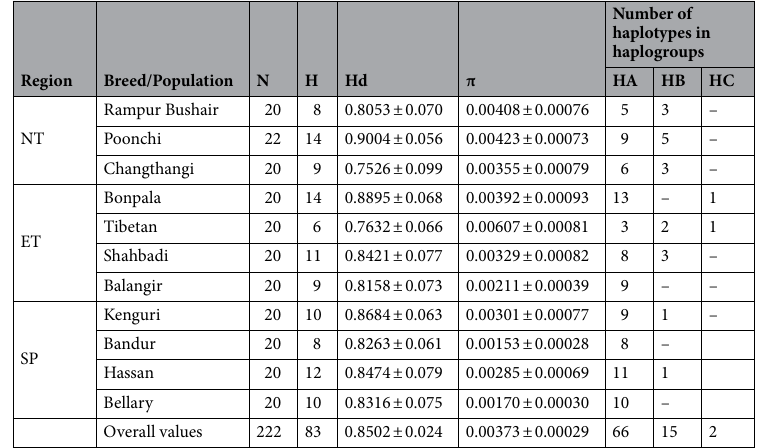
Table 1. Genetic diversity indices of 11 Indian sheep breeds based on mitochondrial D loop sequence. N = Sample size; H = Number of haplotypes; Hd = Haplotype diversity; π = Nucleotide diversity; HA = Haplogroup A; HB = Haplogroup B; HC = Haplogroup